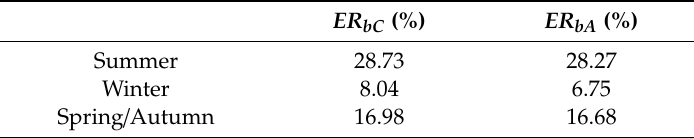
Table 3. Whole-body ER for children and adults in di ff erent